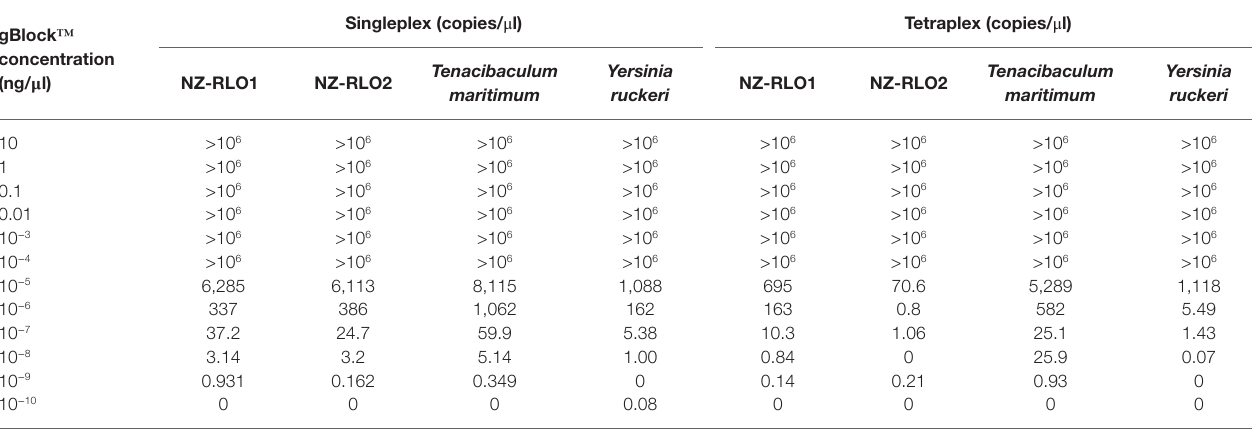
TABLE 2 | Droplet digital PCR results on singleplex and tetraplex assay in copies/ μ l on a 10-fold dilution series of NZ-RLO1, NZ-RLO2, Tenacibaculum maritimum , and Yersinia ruckeri gBlocks ™ starting from 10 ng/ μ